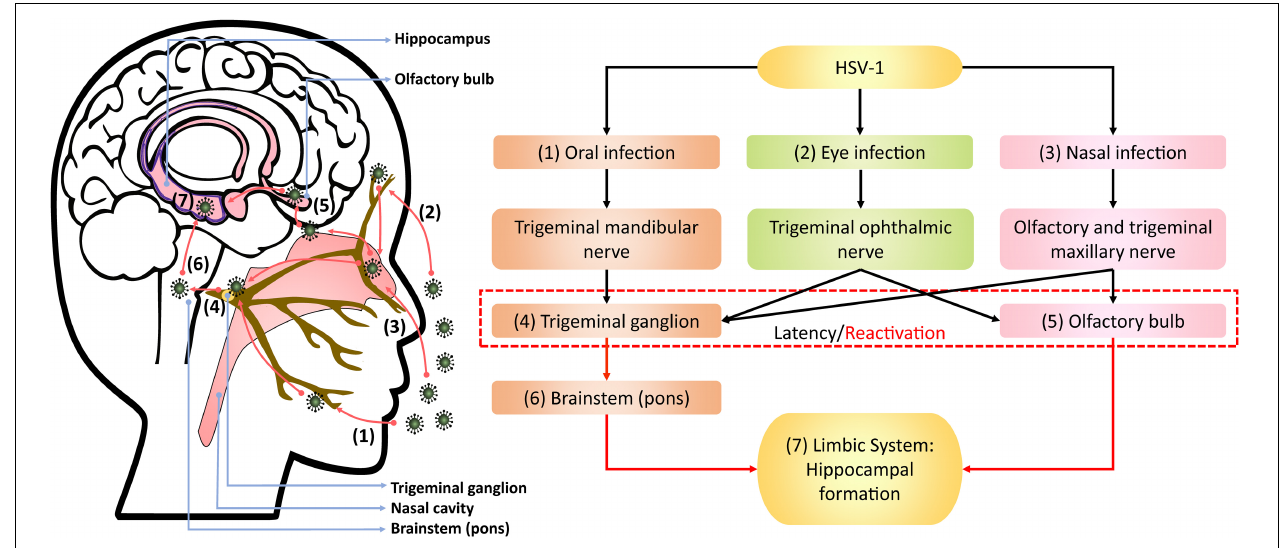
FIGURE 1 | Theoretical model of HSV-1 infection trajectory within the nervous system. Following viral replication in the (1) oral, (2) corneal, or (3) olfactory epithelial cells, HSV-1 can exploit the neuronal retrograde machinery to reach the (4) trigeminal ganglion and (5) olfactory bulb, which are also sites for HSV-1 latency and stress-induced reactivation. Reactivated HSV-1 relies on anterograde transport to infiltrate the brain. Therein, HSV-1 travels from the trigeminal ganglion to the (6) pons, a part of brainstem innervated by the trigeminal nerve, and then to the (7) limbic system that inhabits the hippocampal-entorhinal circuitry. Alternatively, HSV-1 may directly infect the hippocampal-entorhinal circuity via the olfactory bulb, which is part of the limbic